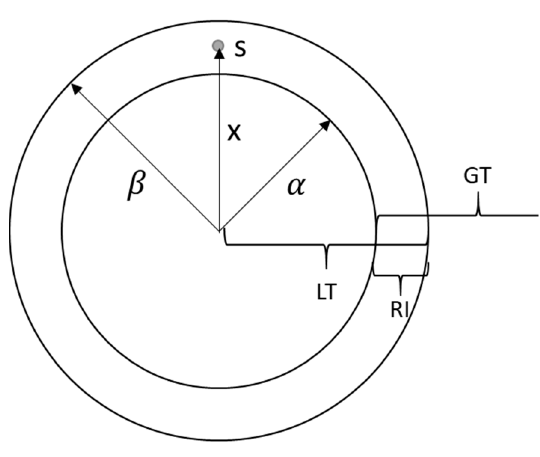
Figure 3. Parameters of a ring .